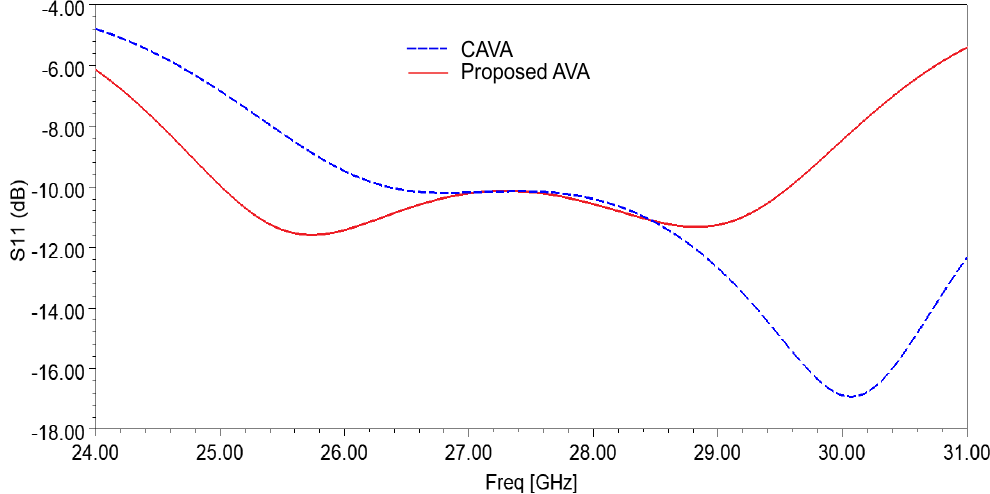
Figure 3. Reflection coefficient of the single-patch AVA with and without